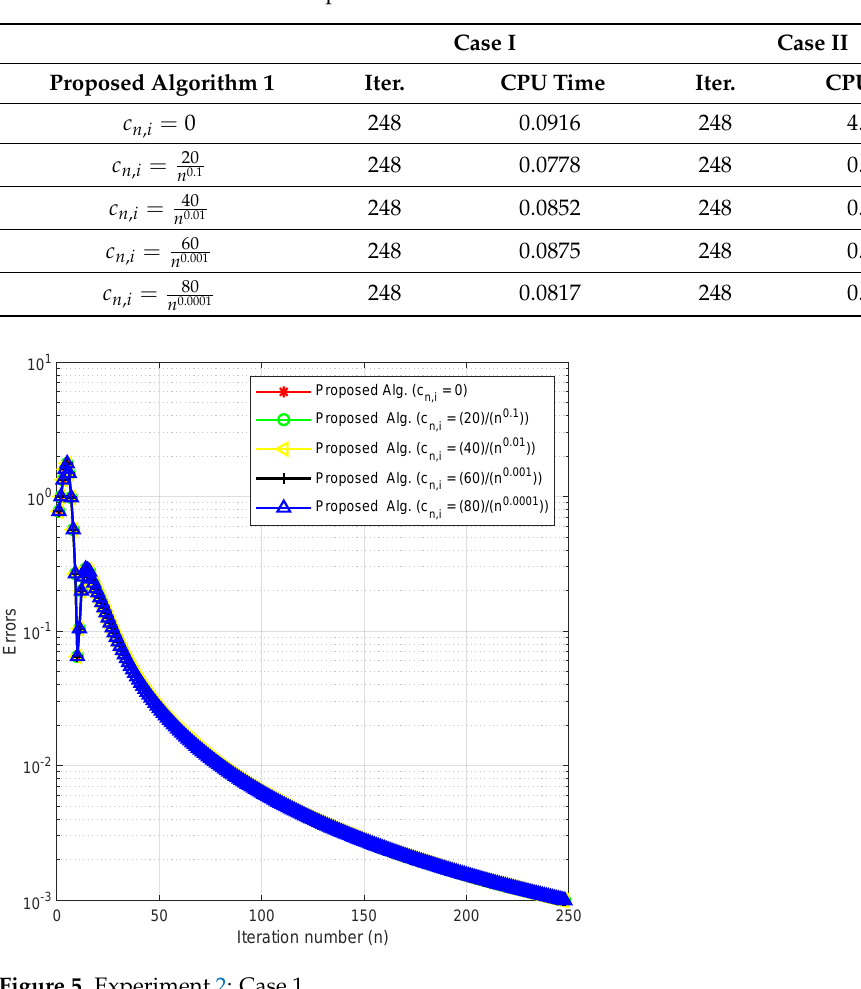
Table 2. Numerical results for Experiment 2.